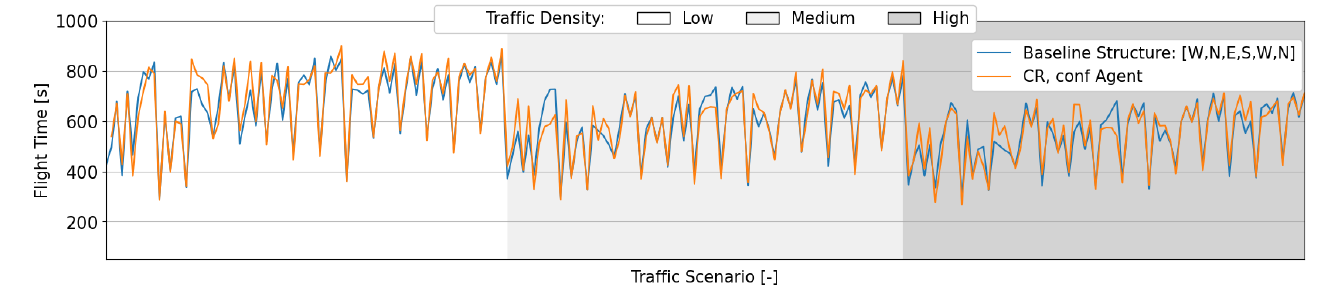
Figure 23. Flight time per aircraft. All traffic densities had 75 traffic scenarios, with the initial direction(s) and the number of turns following the same order as shown during the training